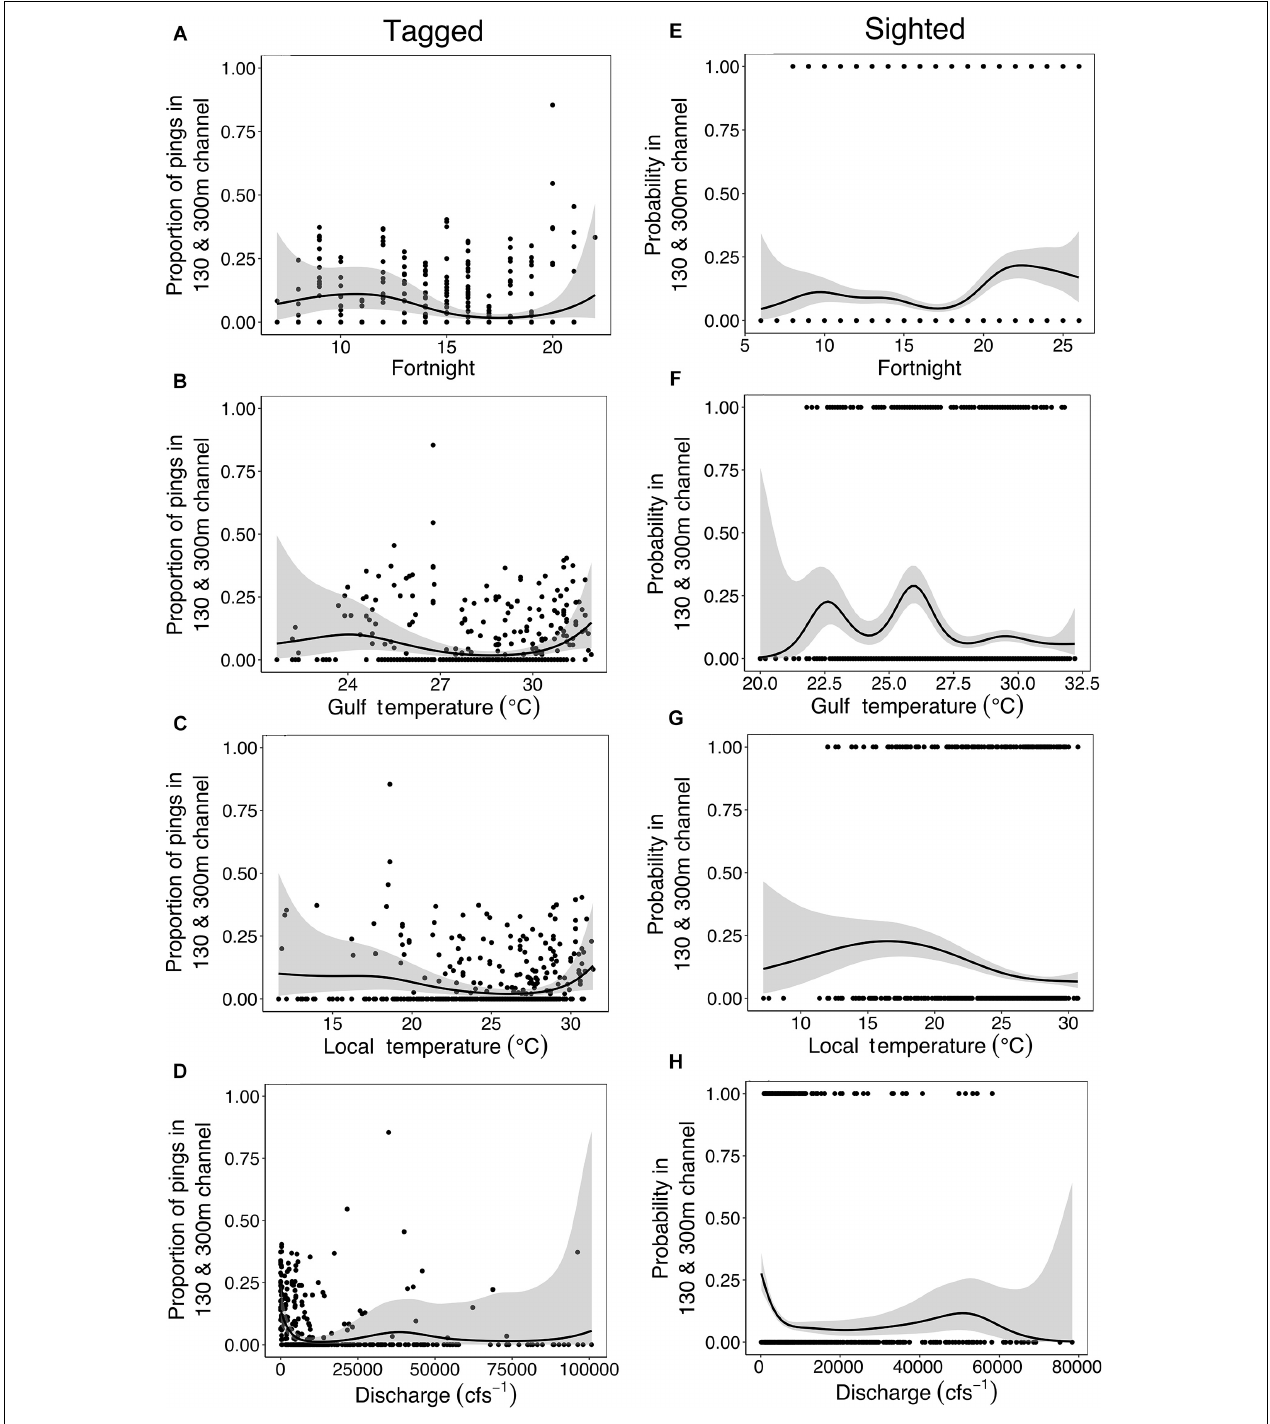
FIGURE 6 | Smoothing curves for fortnight (A,E) , nGoM water temperature (B,F) , local air temperature (C,G) , and freshwater discharge (D,H) from the generalized additive models for tagged (left column) and sighted (right column) manatees in the 130 and 300 m boat channels.